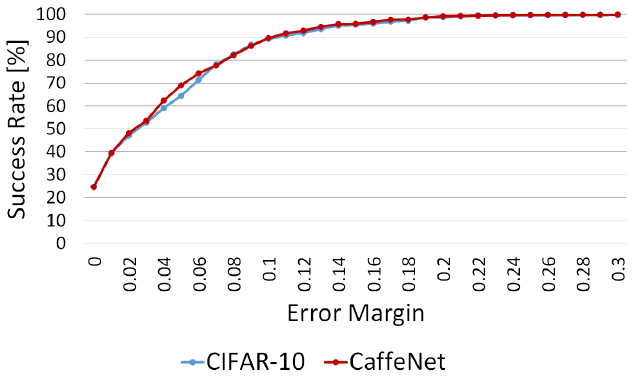
Figure 12. Average success rate for on-shelf availability for all the shelves at various error margins in experiment